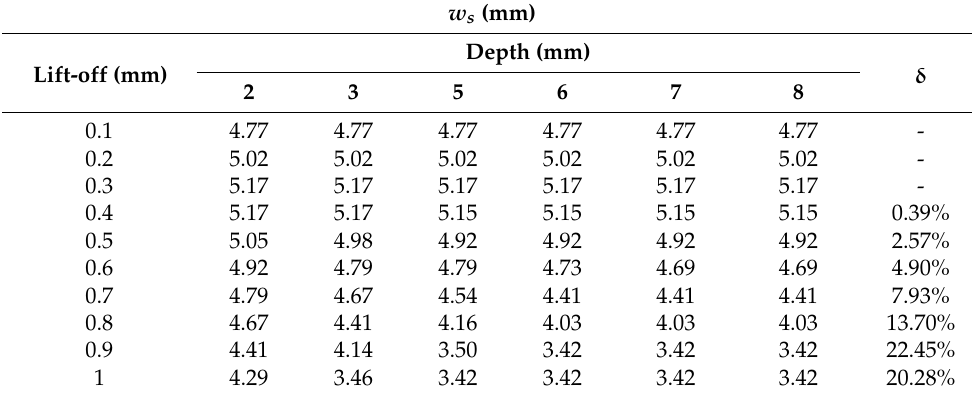
Table 2. Values of w s (width = 5 mm, lift-off = 0.1~1 mm, and depth = 2~8 mm).